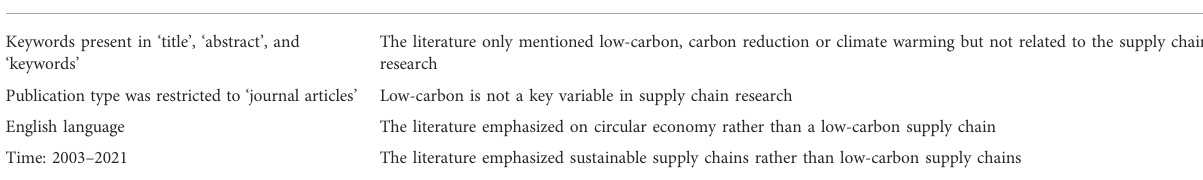
TABLE 2 Inclusion and exclusion criteria for screening records. Inclusion